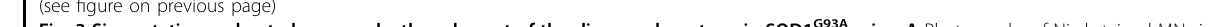
Fig. 3 Simvastatin accelerated neuron death and onset of the disease phenotype in SOD1 G93A mice. A Photographs of Nissl-stained MNs in the ventral horn of the lumbar spinal cord at 120 days. Immuno fl uorescence labeling of CHAT, GFAP, and Iba1 in the lumbar spinal cord at 120 days. (Scale bars, 100 μ m). B The number of MNs in the lumbar spinal cord in different groups. Quanti fi cation of CHAT positive cells in the lumbar spinal cord. Quanti fi cation of GFAP intensity in the lumbar spinal cord. Quanti fi cation of Iba1 intensity in the lumbar spinal cord. (Data represent the mean ± SEM, n = 5 mice per group; statistical signi fi cance was assessed by one-way ANOVA or an unpaired t -test, * P ≤ 0.05, ** P ≤ 0.01, *** P ≤ 0.001, # P ≤ 0.05, ## P ≤ 0.01, ### P ≤ 0.001). C – E Kaplan – Meier plots showing the effects of simvastatin treatment on disease phenotypes. C The body weight curves of WT and SOD1 G93A mice treated or untreated with simvastatin. Simvastatin accelerates body weight loss in SOD1 G93A mice. D The probability of disease onset for G93A-Sim relative to G93A-Con. E The probability of survival for G93A-Sim relative to G93A-Con. Compared to G93A-Con mice, G93A-Sim mice display earlier disease onset and shortened survival. (Data represent the mean ± SEM, n = 18 mice per group; * P ≤ 0.05, ** P ≤ 0.01,